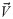
Top-down view of an object with speed vector V→ relative to an observer (camera or radar).